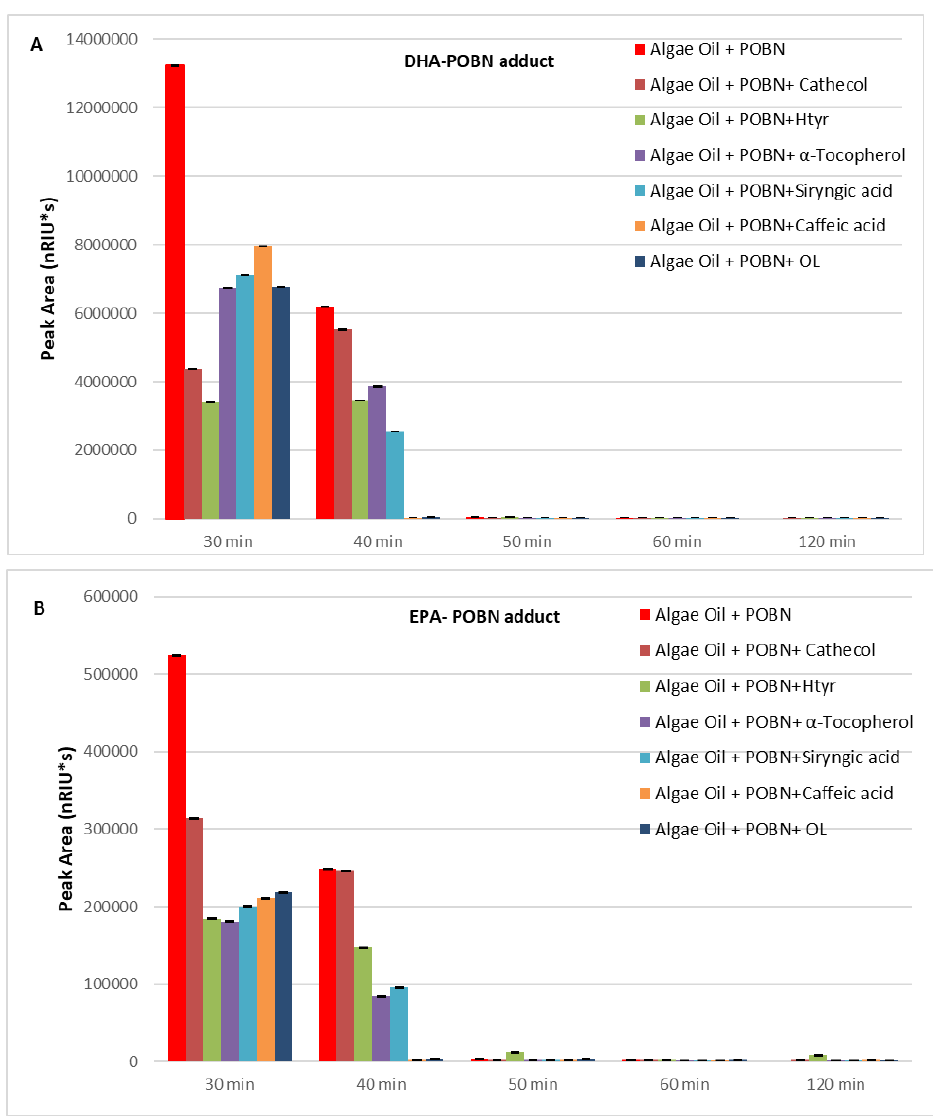
Figure 5. ( A ) Monitoring DHA + POBN adduct; ( B ) Monitoring EPA + POBN adduct.